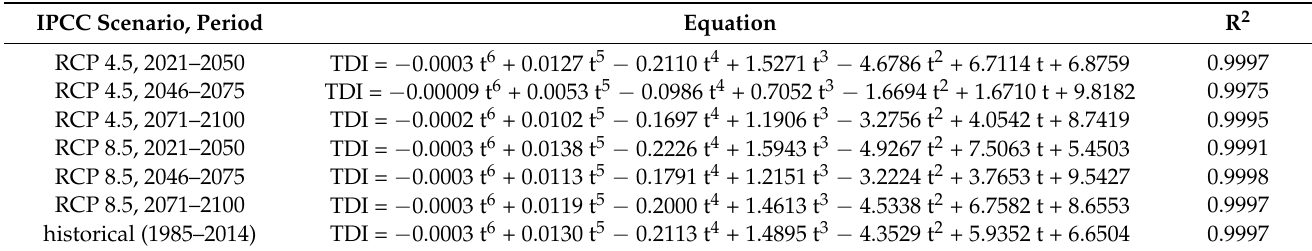
Table 6. Best-fit 6th-order polynomial regression equations for the monthly mean TDIs (in ◦ C); t is the month of the year in the range 1–12; R 2 is the coefficient of